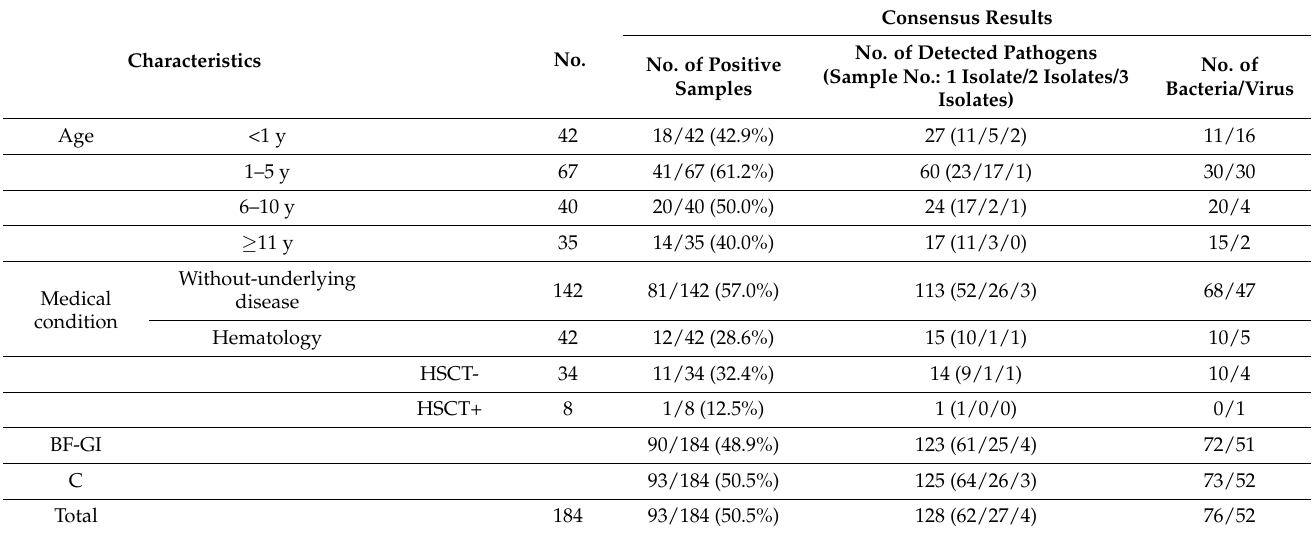
Table 2. Characteristics of 184 patients and summary of the detected